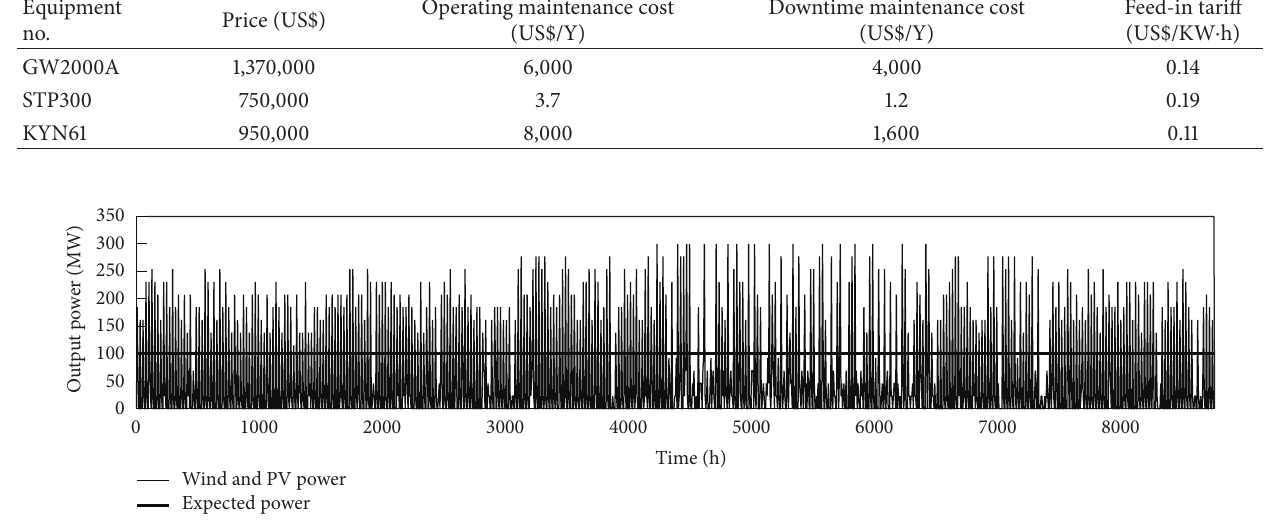
Figure 6: Annual output power curve of the wind-PV-battery unit.